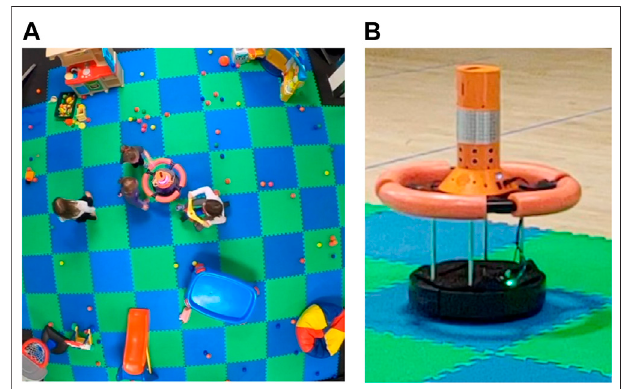
FIGURE 1 | A Overhead view of the play area with developmentally appropriate toys and the SAR; B SAR in the play